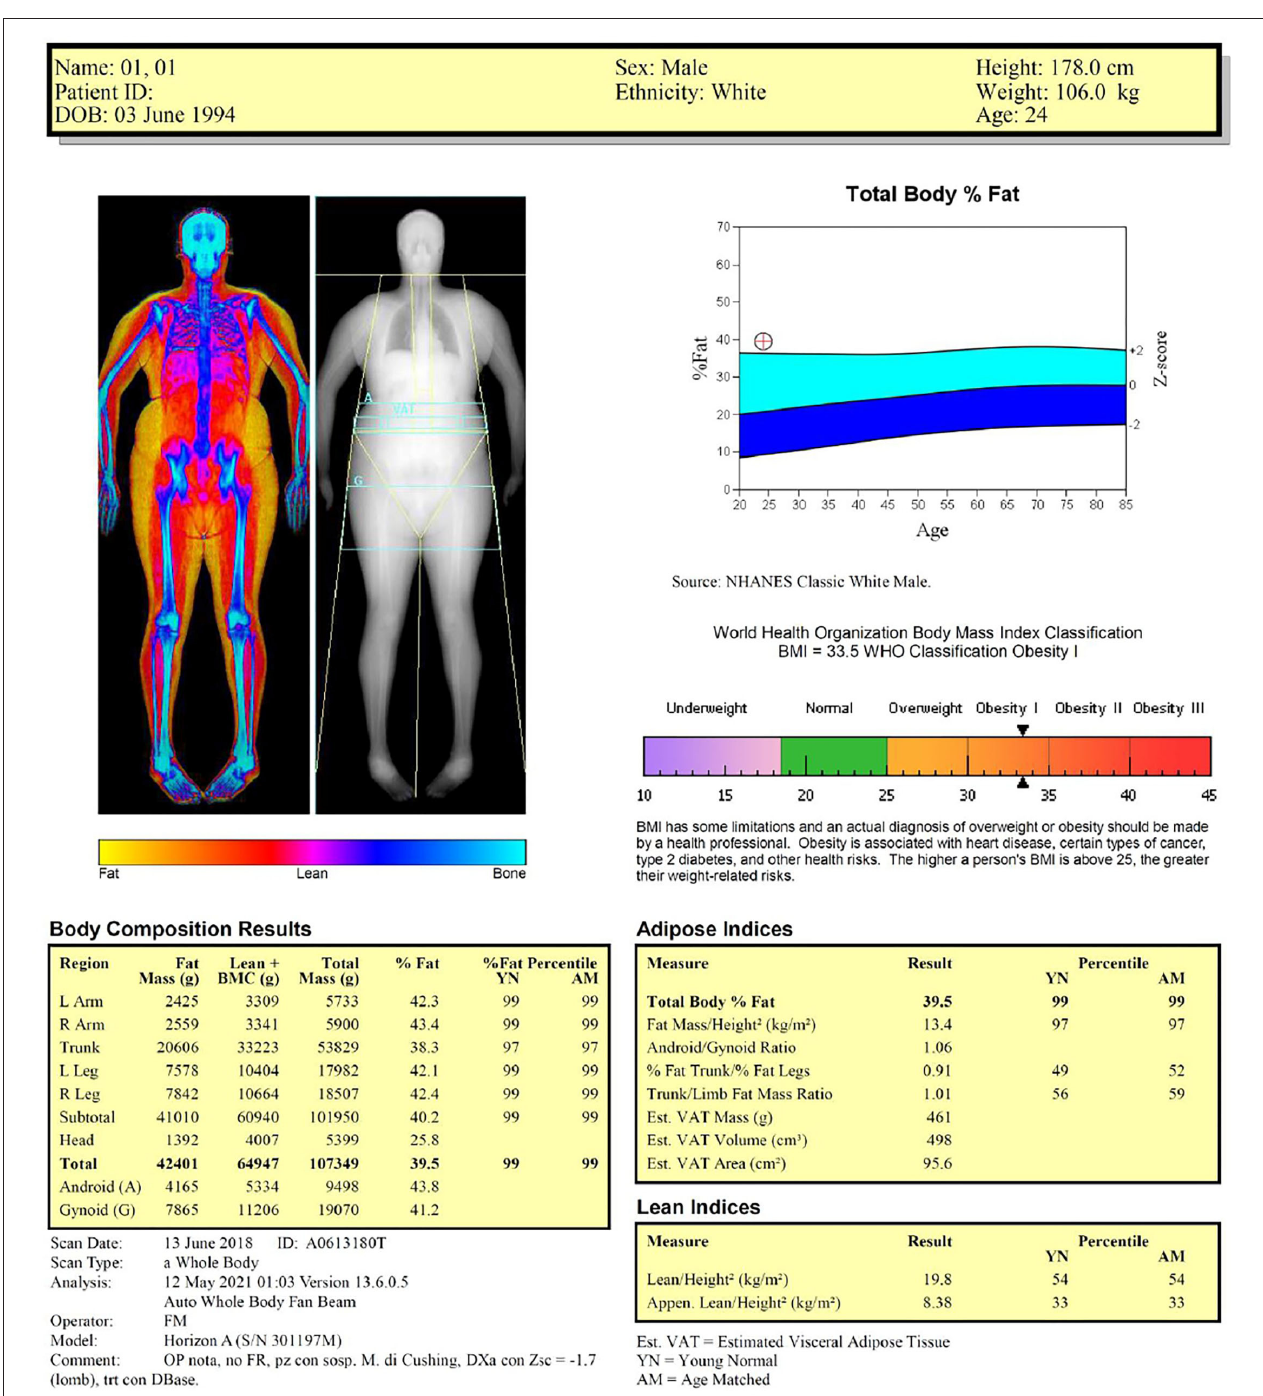
FIGURE 3 | Dual-energy X-ray absorptiometry report of body composition for one representative obese male subject.